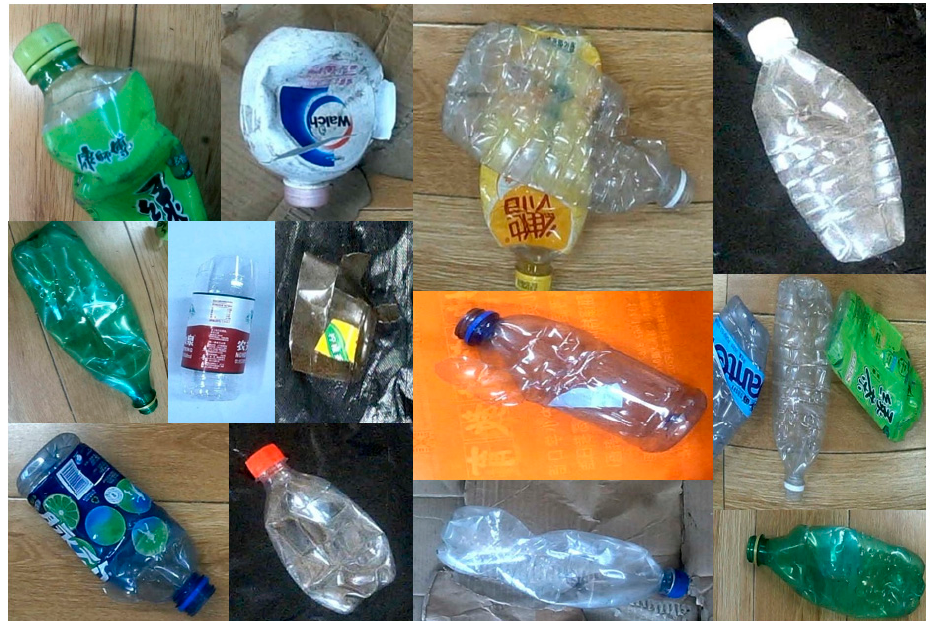
Figure 3. Our waste bottle images from the collected dataset. There are 3902 images in the datasets. We randomly picked 3224 of them as the training set and the others as the test set. These images are classified according to three categories, i.e., color, whether the bottle is damaged, and whether the wrapper is removed.